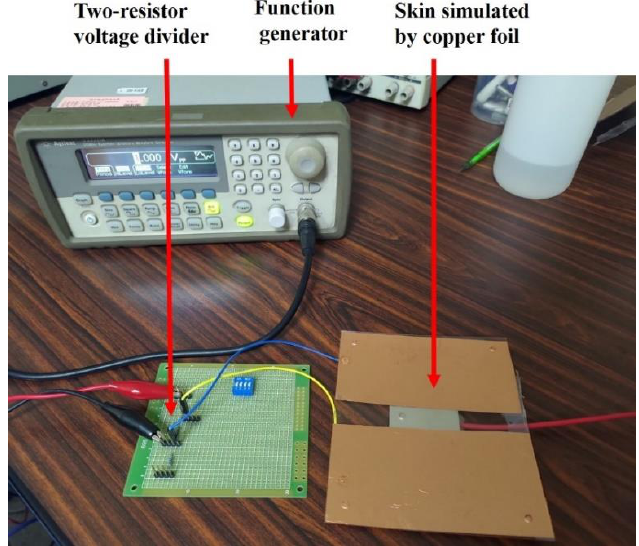
Figure 6. A simulated ECG signal source using an Agilent 33220A function/arbitrary waveform generator and a two-resistor voltage divider.